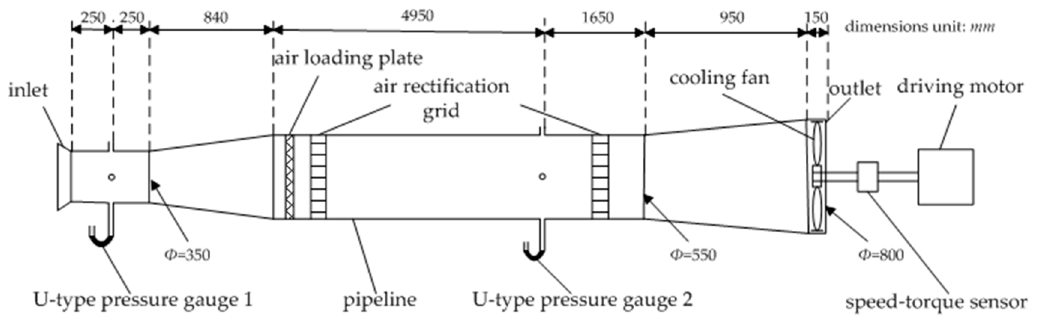
Figure 3. Schematic diagram of axial-cooling fan test bench.